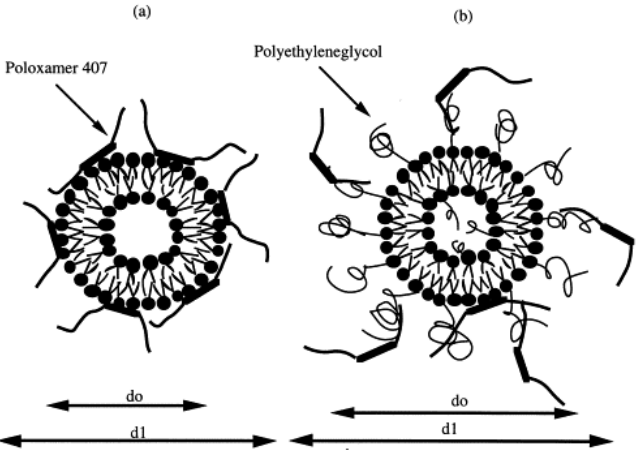
Figure 4. Mechanism of interaction between P407 and conventional ( a ) or sterically stabilized ( b ) liposomes. (d 0 = diameter of liposomes); (d 1 = diameter of liposomes embedded in P407) [92].